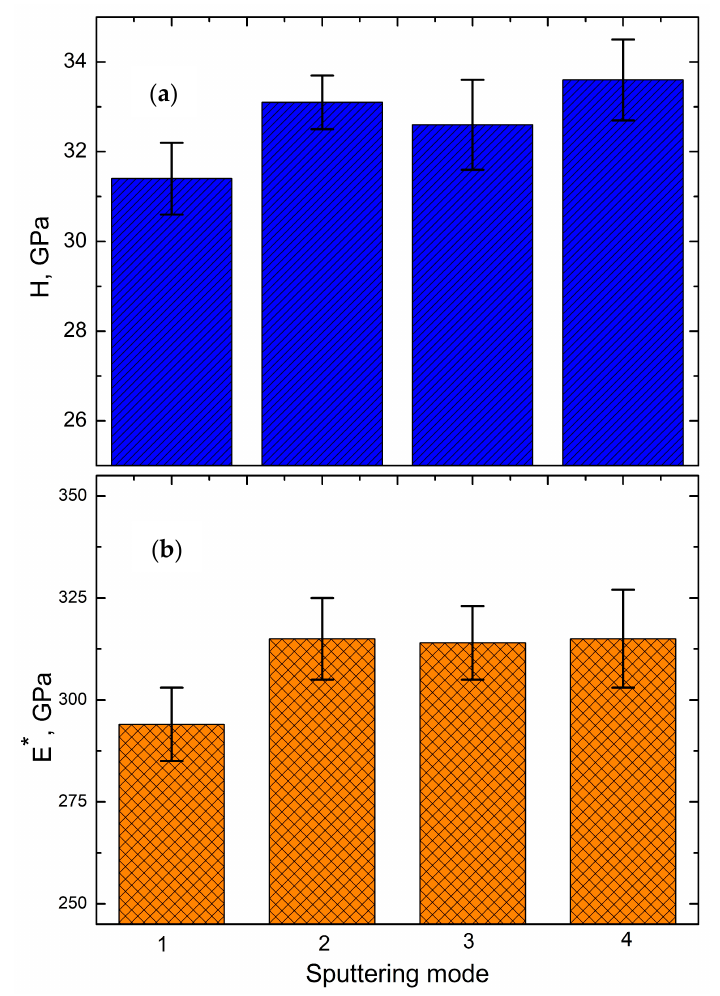
Figure 4. Hardness ( a ) and reduced Young’s modulus ( b ) of the Ti-Al-Ta-N coatings obtained in different sputtering modes.